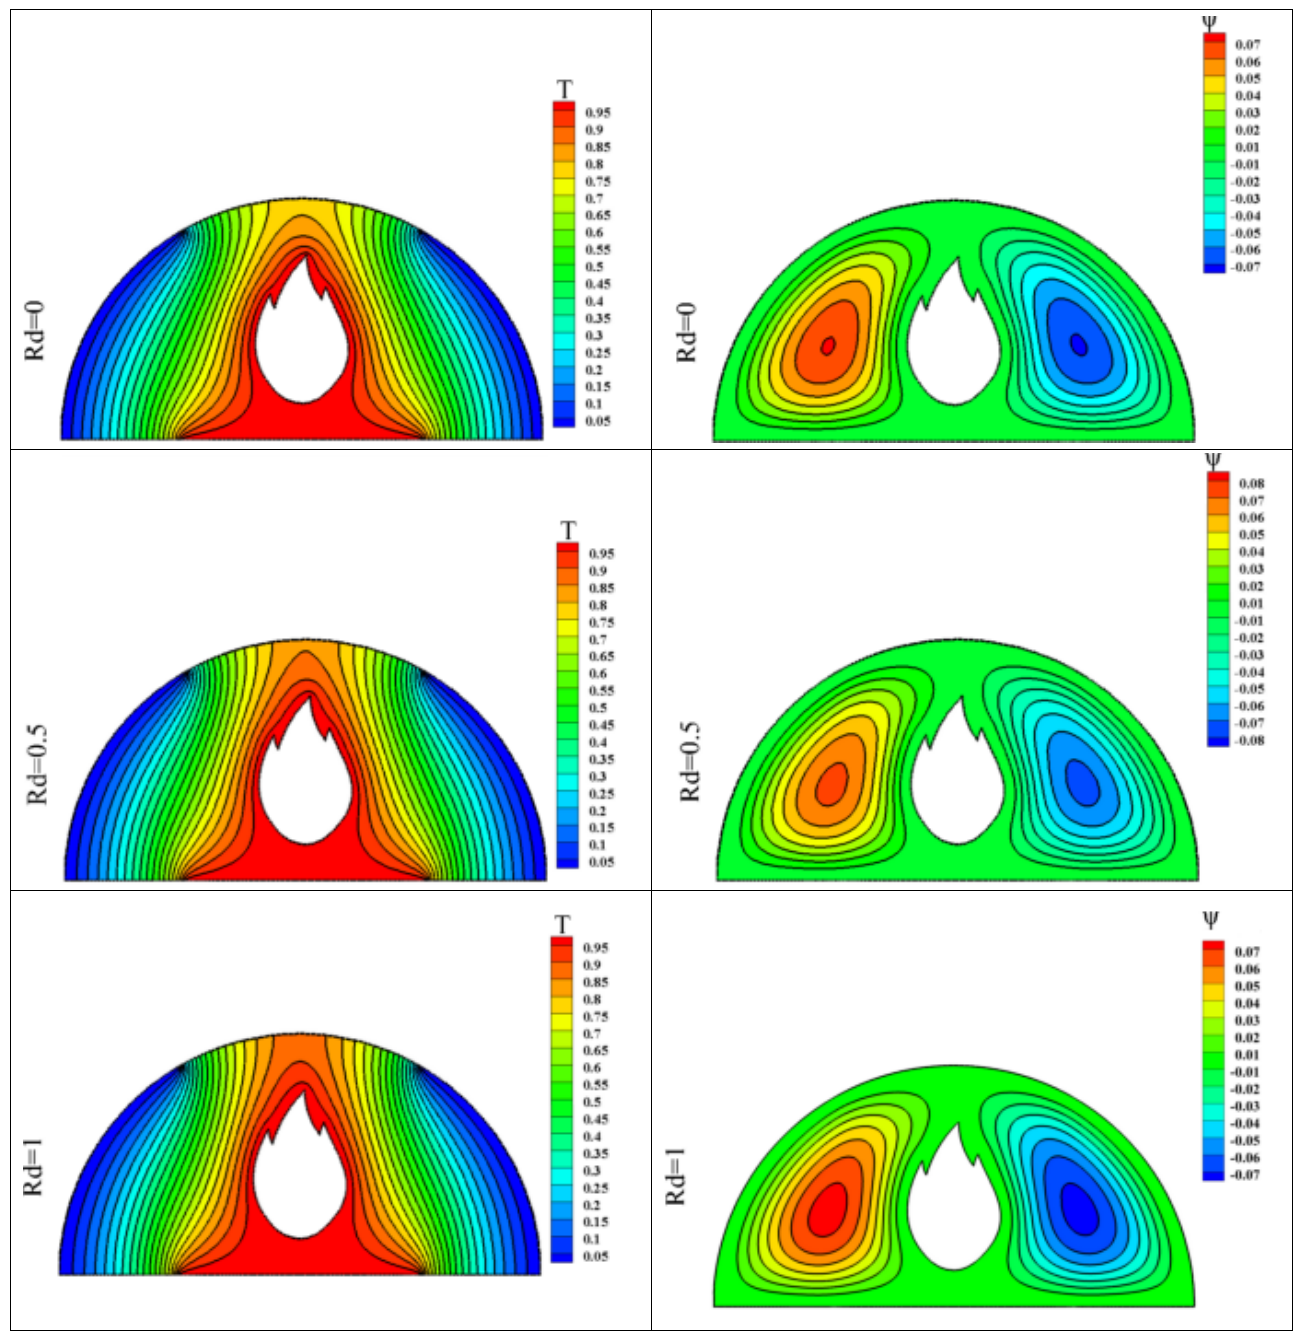
Figure 13. Streamlines ( right ) and isotherms ( left ) inside the enclosure for various values of radiation parameter at ( φ = 0.02, L = 0.2, Ha = 50, Da = 10 − 4 and Ra = 10 5